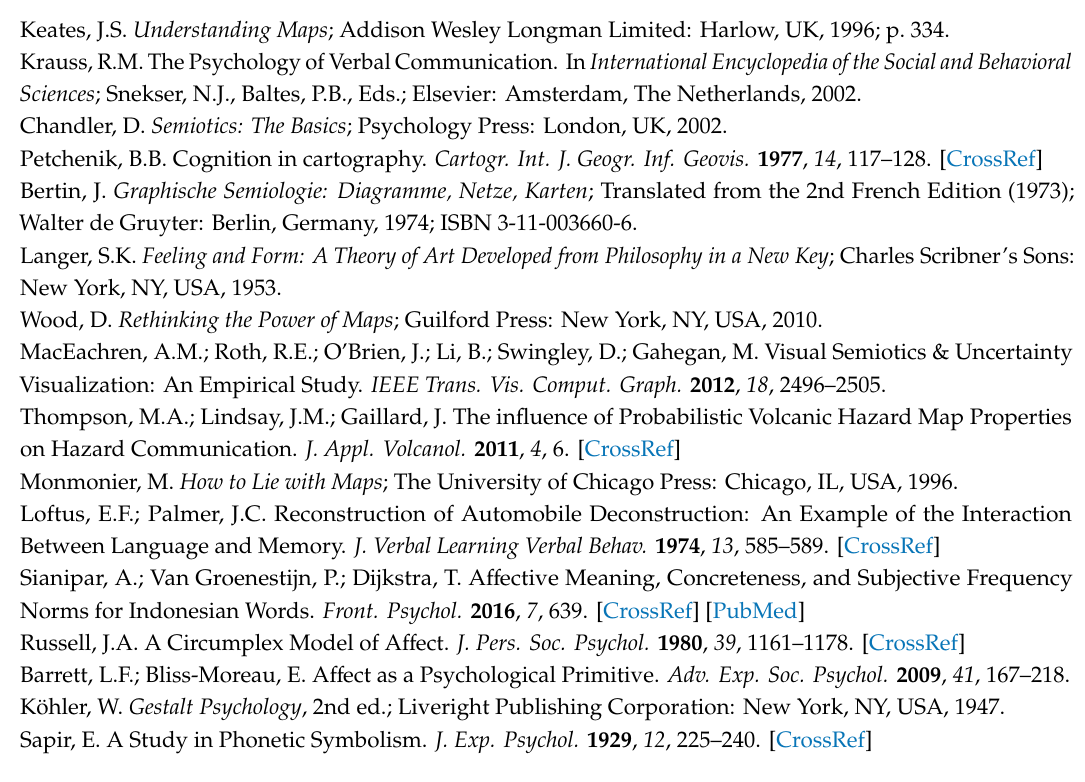
Figure S1: Scree plot based on PROXSCAL MDS for ordinal data, based on the 12x12 co-occurrence matrix, indicating a two-dimensional configuration. Table S1: Hierarchical agglomerative cluster analysis dissimilarity matrix. Frequencies according to Phi-Square. Table S2: Goodness of Fit for a two-dimensional MDS configuration, based on a 12x12 co-occurrence matrix. Table S3: Coordinates for Common Space by applying a two-dimensional MDS configuration, based on a 12x12 co-occurrence matrix. Table S4: Excerpt of the inductive category formation process and coding results of coder 1 (translated from German). Table S5: Cross-tabulation of female versus male responses of the three strategies identified, based on the results of coder